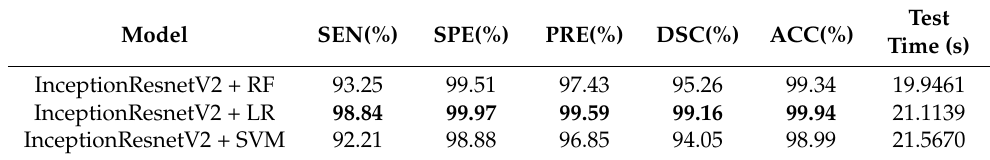
Table 10. The performance evaluation for InceptionResnetV2 combined with different